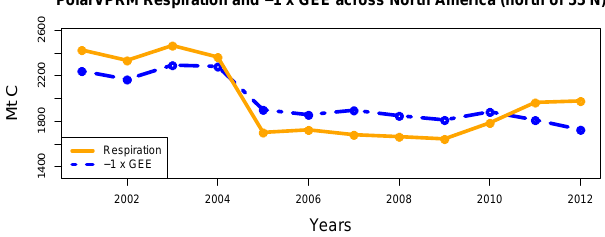
Figure 5. Relative contributions of PolarVPRM respiration and photosynthesis (GEE, plotted here as − 1 × GEE) to inter-annual variability in the net C balance of the North American terrestrial region north of 55 ◦ N